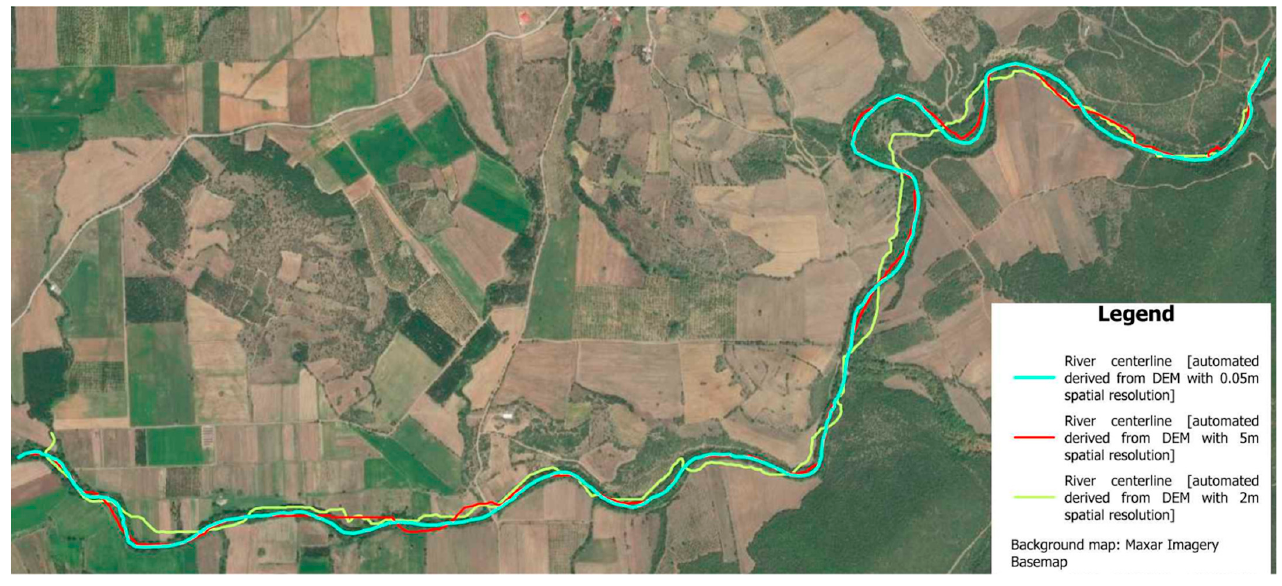
Figure 15. River centerlines derived from the 3 DTMs projected on the same map (see SM30) for comparison purposes. All simulations are based on “ground truth” centerline (by DTM_0.05 m).